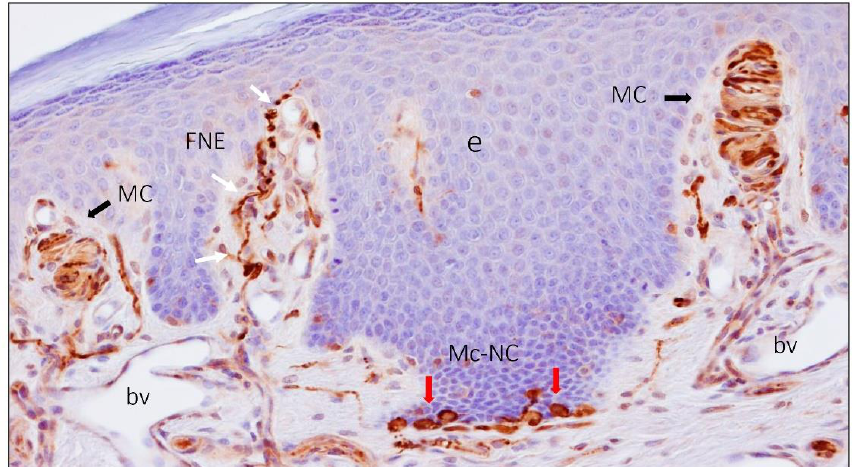
Figure 2. Section of human digital skin immunostained for the demonstration of neuron-specific enolase that labels axons in nerve fibers and sensory corpuscles as well as Merkel cells. FNE: free nerve ending (white arrows); MC: Meissner cor- puscles (black arrows); Mc-NC: Merkel cell–neurite complex (red arrows). bv: blood vessels; e: epidermis.